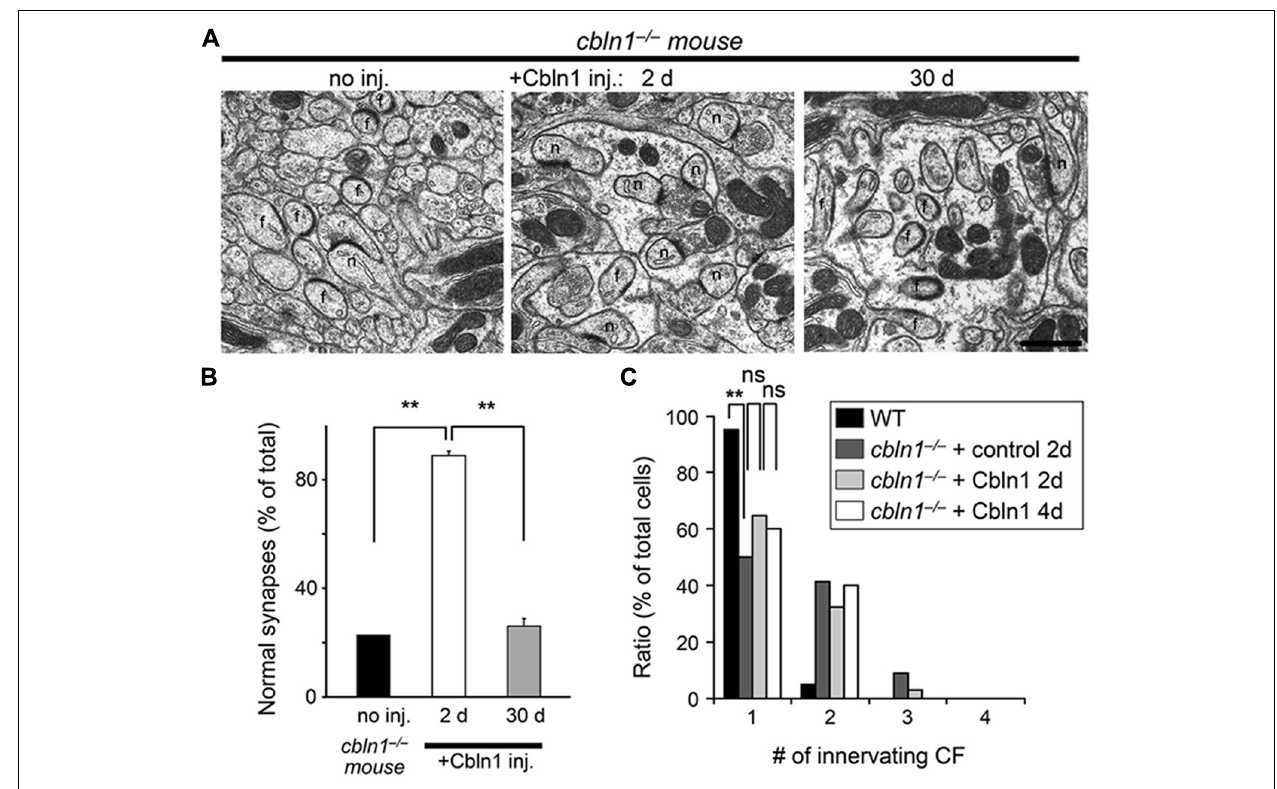
FIGURE 4 | Subarachnoidal Cbln1 injection transiently restores PF–Purkinje cell synapse structure in cbln1 − / − mice. (A) Electron micrographs of the molecular layer in cbln1 − / − mice aged P42–P54 without Cbln1 injection (no inj) and at 2 or 30 days after Cbln1 injection. f, free spines without innervation by presynaptic structures; n, normal spines. Scale bar, 500 nm. (B) The percentage of normal synapses in cbln1 − / − mice with no injection (no inj), or 2 or 30 d after a Cbln1 injection. Significant recovery of normal synapses was observed 2 days after a Cbln1 injection, compared with no injection or their state 30 days after the injection (** p < 0.001, Mann − Whitney’s U test, n = 3 for each group). (C) Cbln1 injection transiently